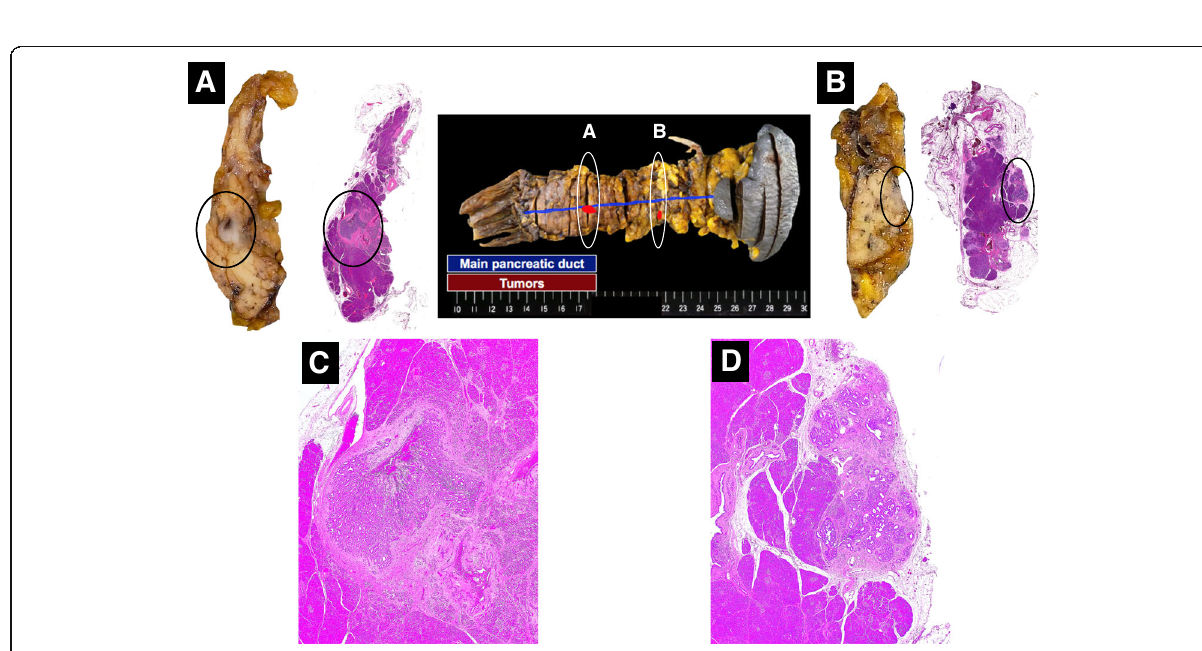
Fig. 4 Pathological findings of the secondary resected specimen of the pancreas body and tail lesions. a , b Two tumors were identified at the pancreas a body and b tail. a A white solid mass (5 mm in diameter) with well-defined margins adjacent to the main pancreatic duct (MPD) was observed in the pancreas body (circle). b A white solid mass (5 mm in diameter) with ill-defined margins farther away from the MPD was also observed in the pancreas tail (circle); this mass had not been detected in the preoperative images. Neither of these tumors exhibited luminal mucin secretion. c , d Microscopic findings of the resected specimen ( c pancreas body lesion, d pancreas tail lesion). c A solid nodular tumor with a dilated MPD was observed (original magnification, ×20). d The tumor with ill-defined margins was farther away from the MPD (original magnification, ×20)